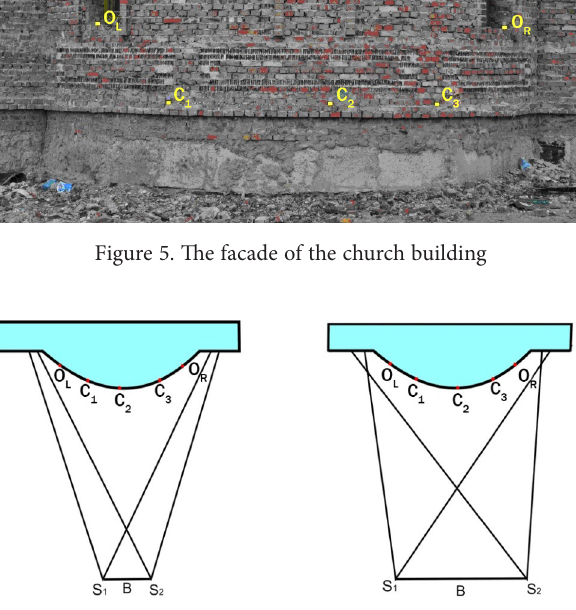
Figure 6. Scheme of the stereo photography. Normal and convergent cases of surveying the facade of a religious